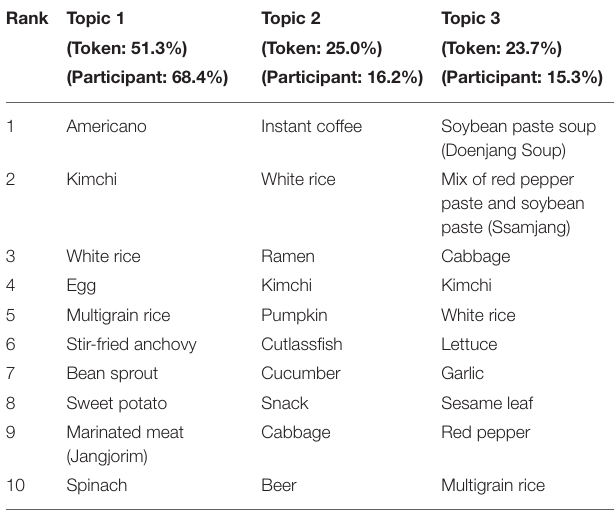
TABLE 2 | Topic-based dietary patterns of